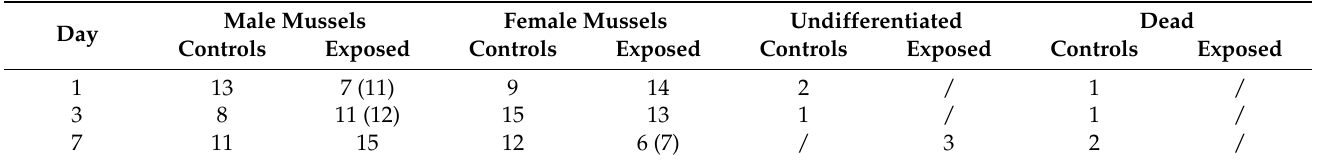
Table 3. Number of mussels in each exposure condition (control or exposed) according to sampling time and